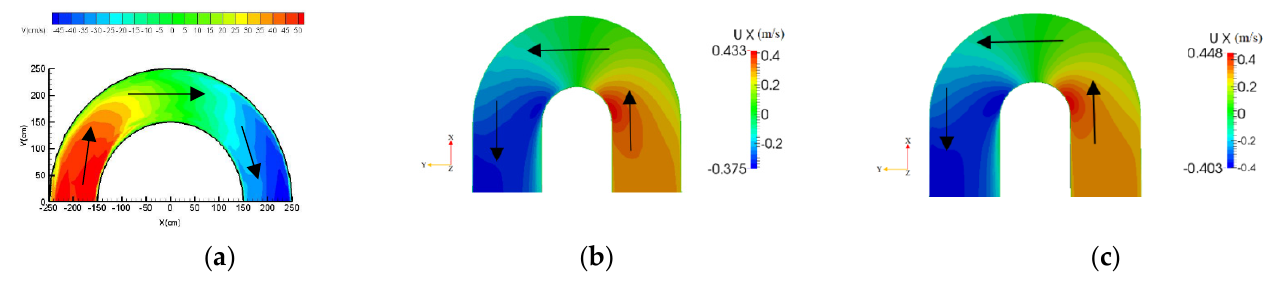
Figure 8. Longitudinal velocity contours. ( a ) contours of longitudinal velocity in the plan views— experiment (Vaghefi et al., 2015) [1]; ( b ) contours of longitudinal velocity in the plan views—simulated (Standard k- ε ); ( c ) contours of longitudinal velocity in the plan views—simulated (Realizable k- ε ).